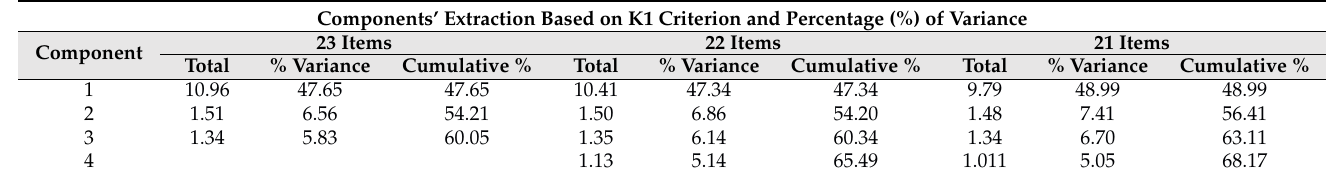
Table 3. Components’ extraction from data based on K1 criterion and total variance explained for RS factor